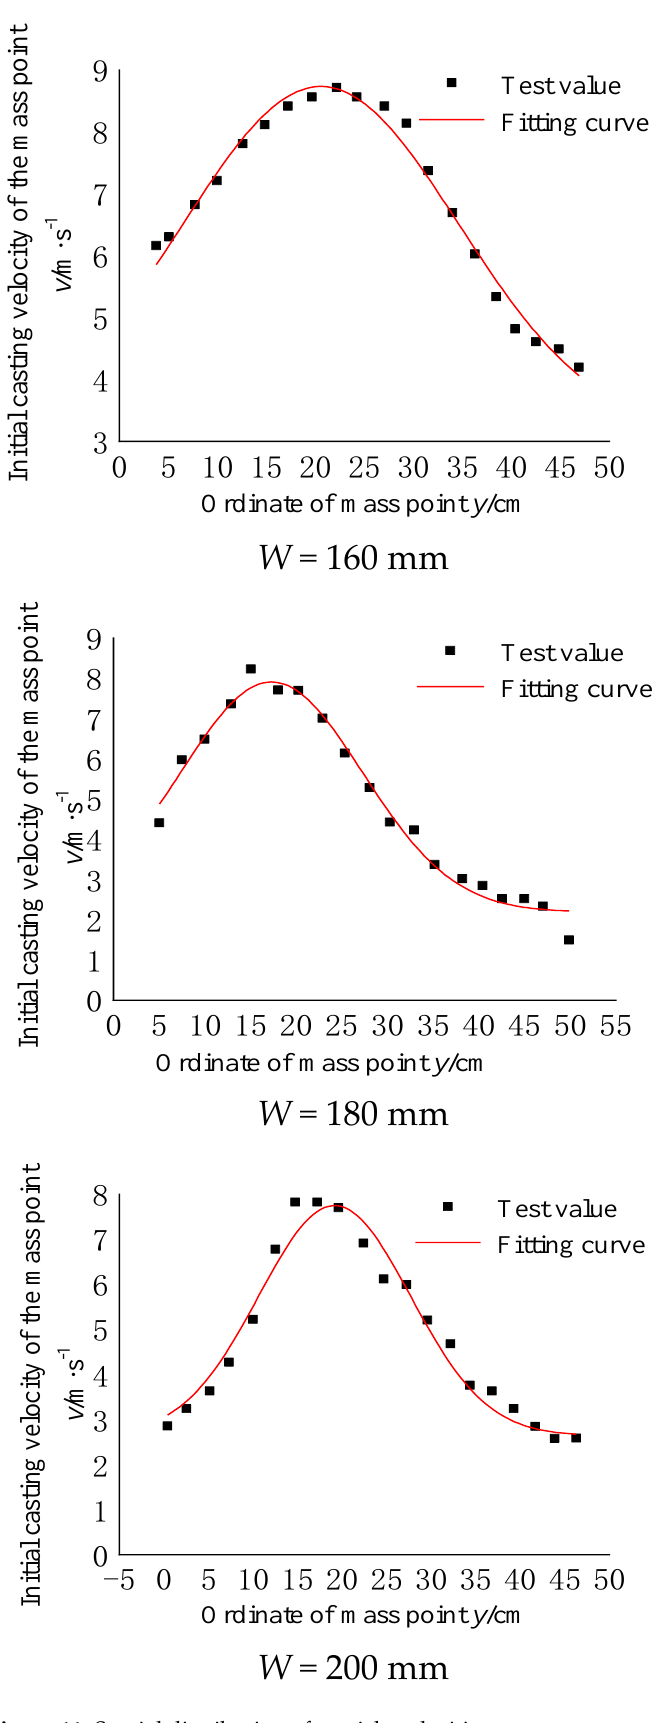
Figure 11. Spatial distribution of particle velocities.